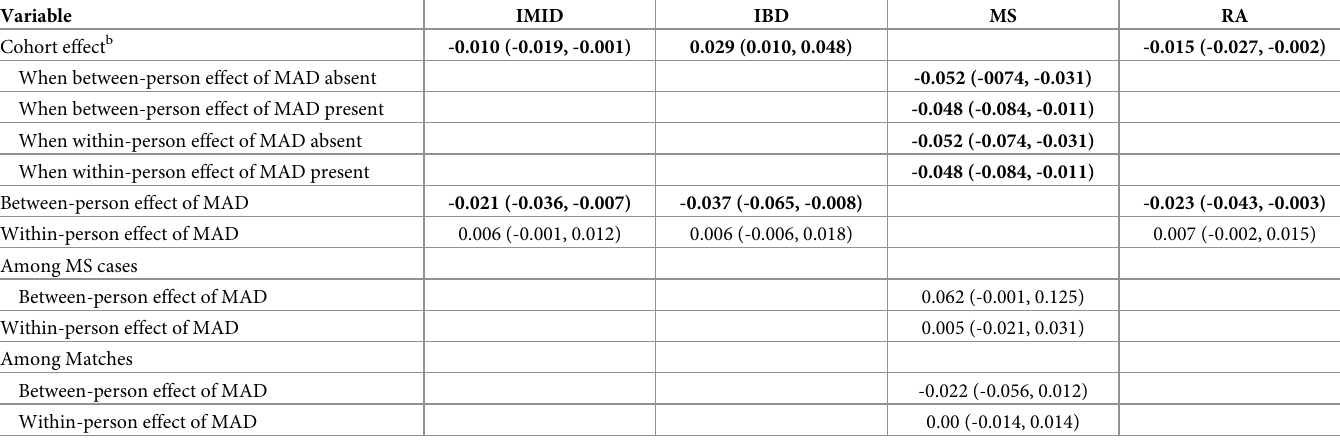
Table 2. Adjusted a association of immune-mediated inflammatory disease (IMID), any mood or anxiety disorder (MAD) and mammogram use (proportion; 95% confidence